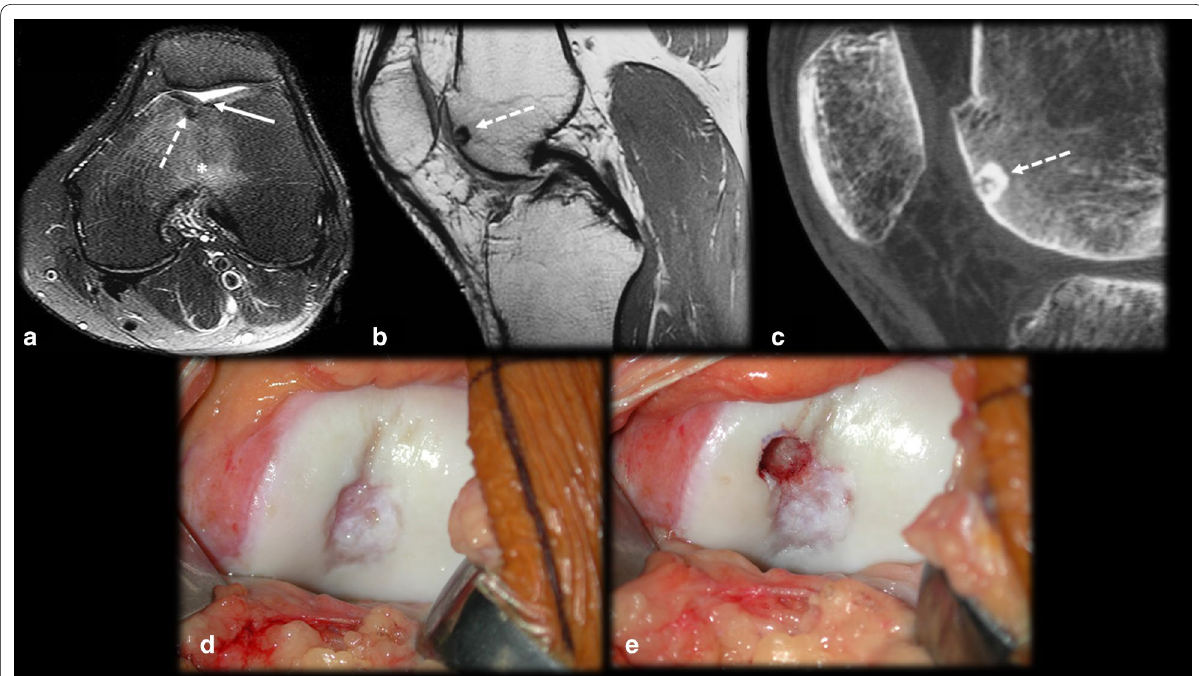
Fig. 7 Subchondral osteoid osteoma mimicking trochlear chondromalacia. A 35-year-old male with anterior knee pain for 4 months. Axial T2 FS MR images ( a ) showed deep chondral erosion (arrow), subchondral edema (asterisk) and a small, low signal intensity foci that could be a nidus (dashed arrow). Sagittal T1 MRI ( b ) and CT ( c ) confirmed the diagnosis of the OO nidus (dashed arrow). Surgical images before ( d ) and after ( e ) resection